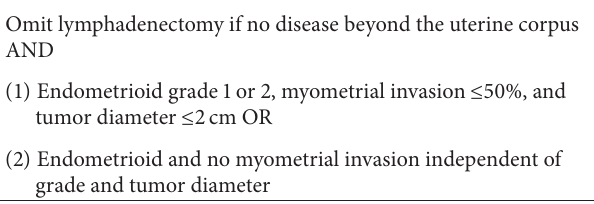
Table4:Mayocriteriaforomissionoflymphadenectomyinsurgical management of endometrial